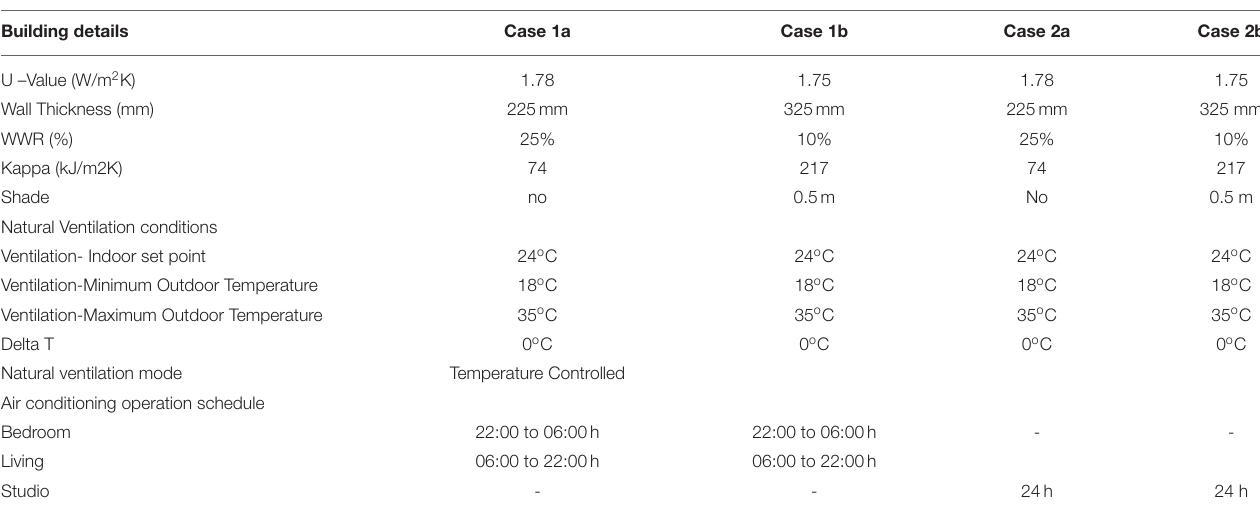
TABLE 1 | Details of building typology selected for